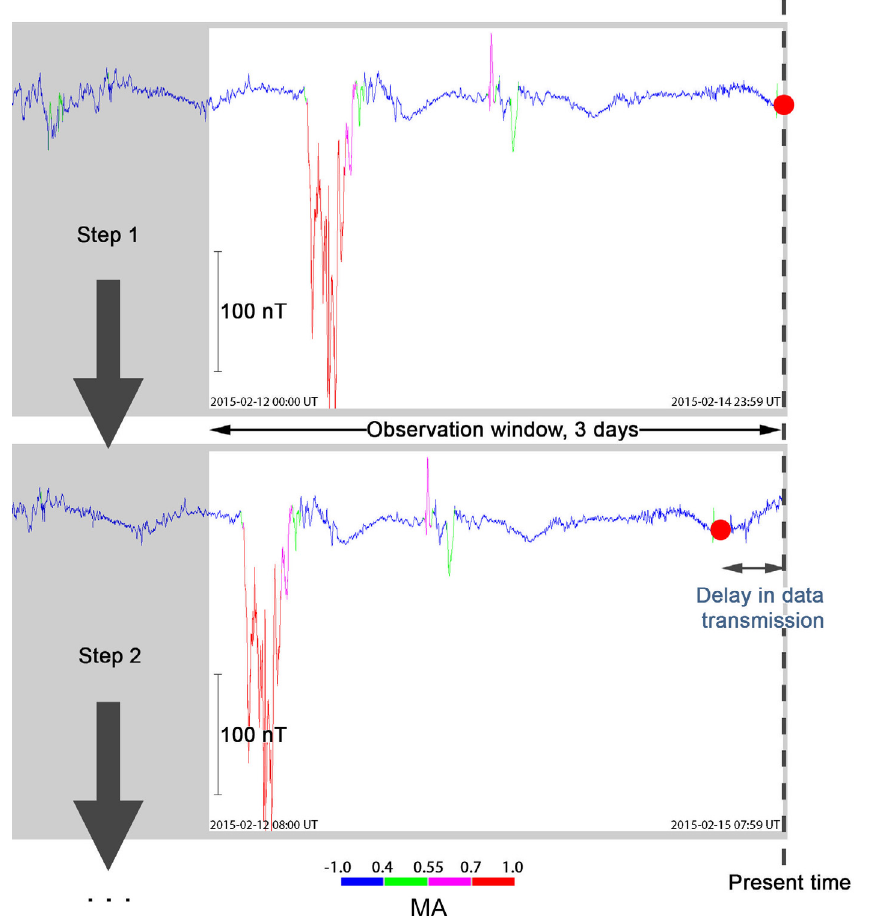
Figure 9. Sequential and continuous recognition of geomagnetic activity within 3-day registration period using MA by example of the data from “Cape Schmidt” (IAGA code CPS) observatory. Observation window shift between previous (‘Step 1’) and subsequent (‘Step 2’) steps of the algorithm operation corresponds to 8-hour delay of data transmission. Red point represents the timestamp of the most recently trans- mitted data at step 1 (right border of observation window). Its shift at step 2 is naturally caused by new 8-hour data